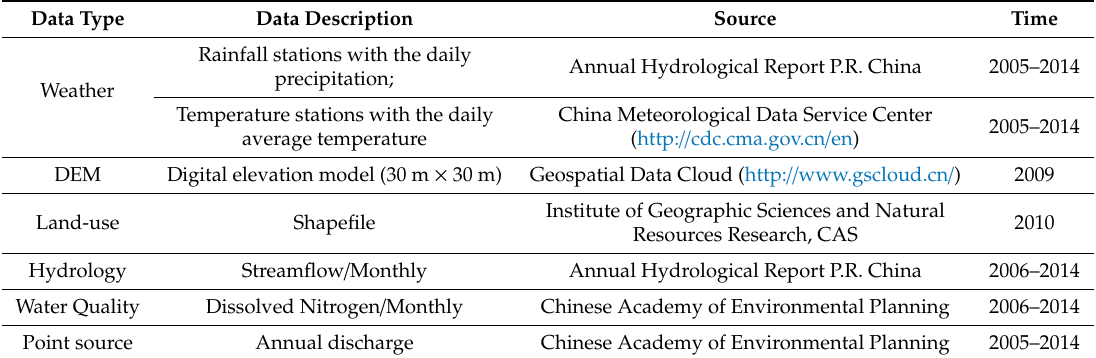
Table 1. Watershed Model input data used in the